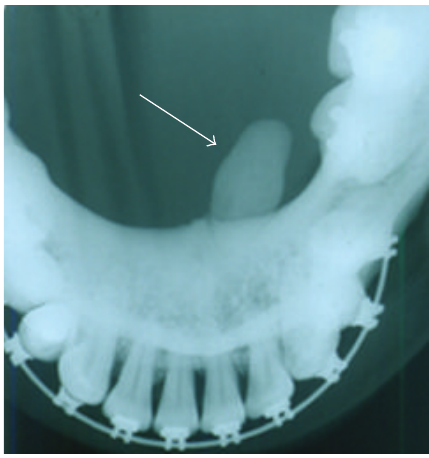
Figure 1: Occlusal radiograph of the massive sialolith (arrow).